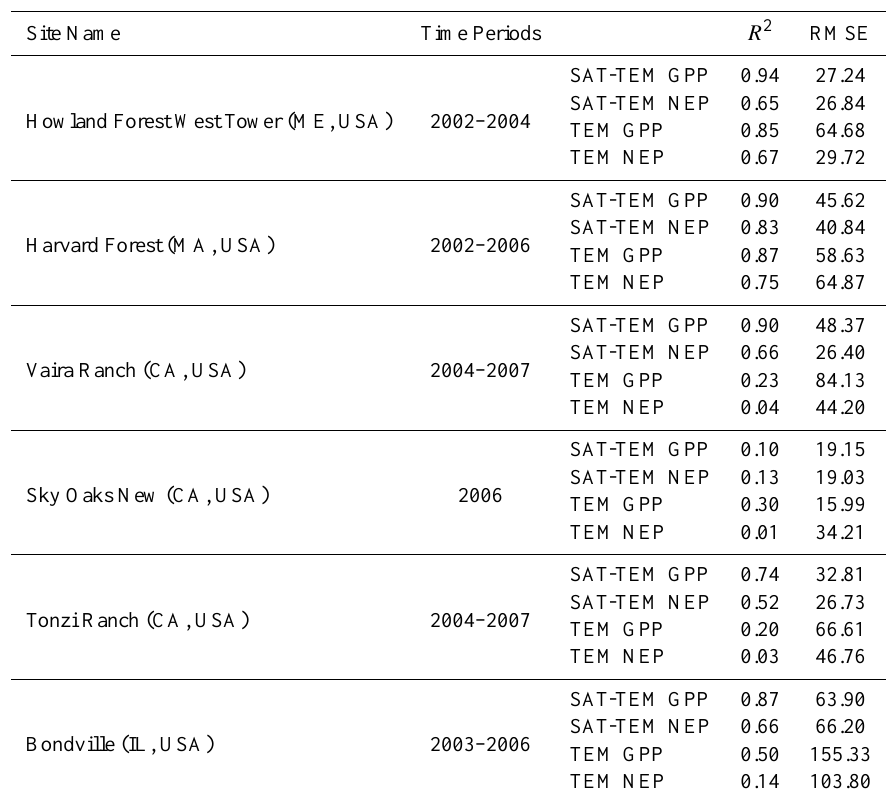
Table 4. Statistical results for the observed and SAT-TEM and TEM predicted monthly GPP and NEP at each AmeriFlux site for parameter- ization. The units of RMSE are gCm − 2 month − 1